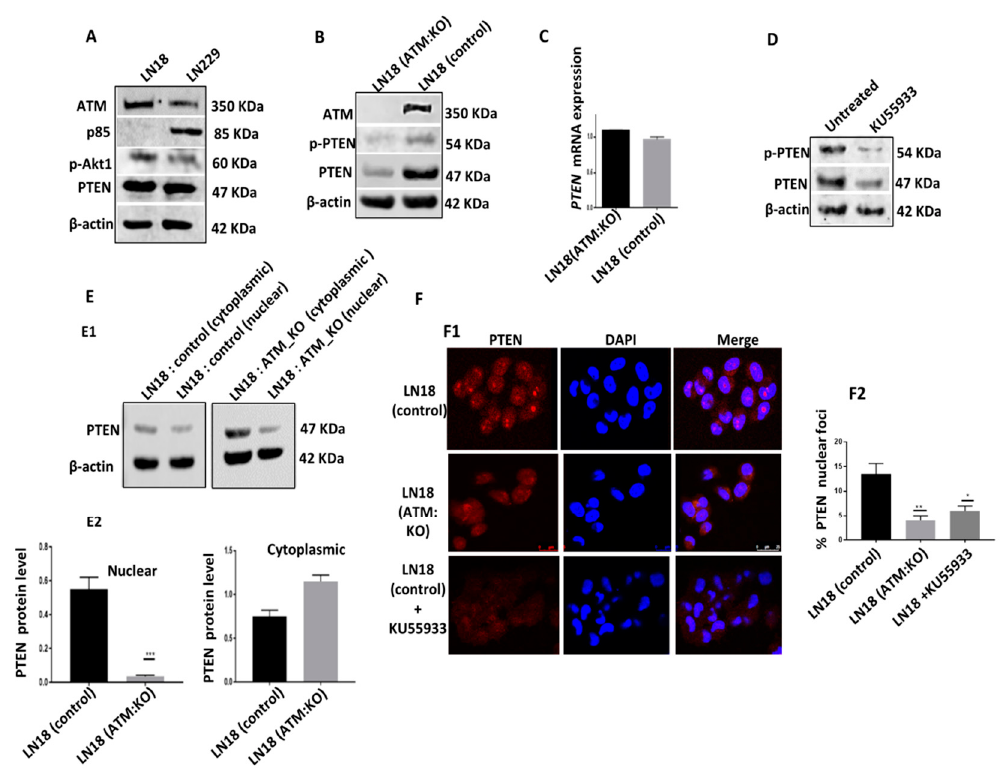
Figure 1. Low PTEN protein level in ATM deficient cells. ( A ) ATM, PTEN, p-AKT1 and p85 α levels in LN18 and LN229 cells. ( B ) LN18 ATM_KO was generated by CRISPR-cas9 and levels of total PTEN and P-PTEN (Ser380 / Thr382 / 383) were assessed by western blotting. ( C ) Relative PTEN mRNA expression was assessed by RT-PCR. ( D ) LN18 control cells were treated with ATM inhibitor KU55933 for 24 h lysates were immunoblotted for PTEN and p-PTEN. ( E ) Nuclear and cytoplasmic fractionation of LN18 control and ATM KO cells. ( F ) Representative photomicrograph images showing PTEN translocation (100 × ). The data are representative of 3 independent experiments. Where appropriate, quantification is summarized in Supplementary Figure